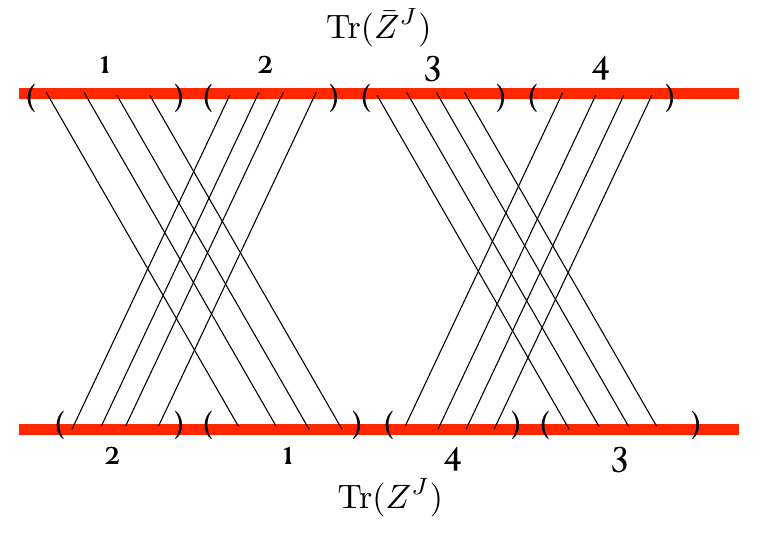
Figure 1 . The torus